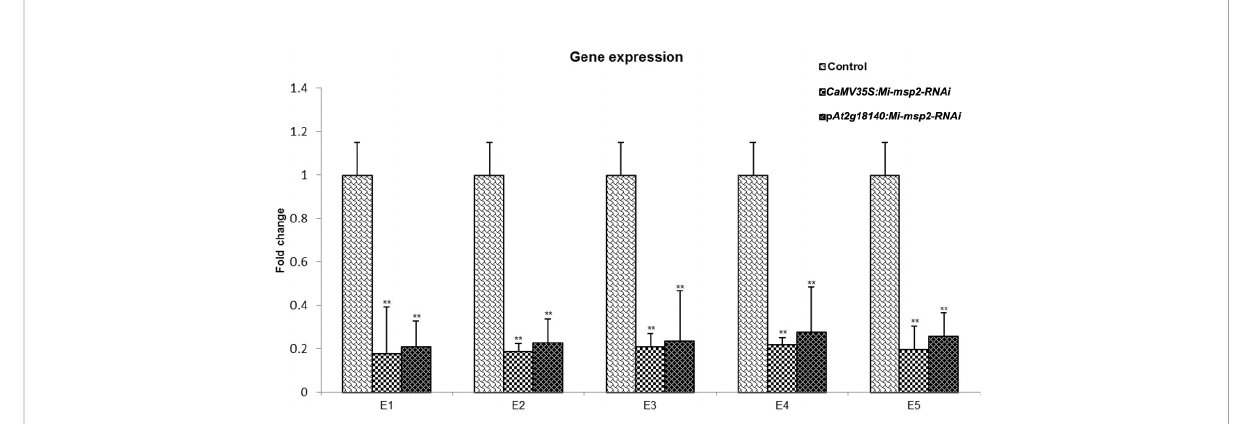
FIGURE 8 qRT – PCR-based expression analysis of M. incognita females isolated from infected roots of the control plants and fi ve independent lines of each RNAi construct CaMV35S::Mi-msp2-RNAi and p At2g18140::Mi-msp2-RNAi . Each bar represents the mean±SE. Double asterisks indicate statistically signi fi cant differences according to one-way ANOVA based on F and P values (p ≤